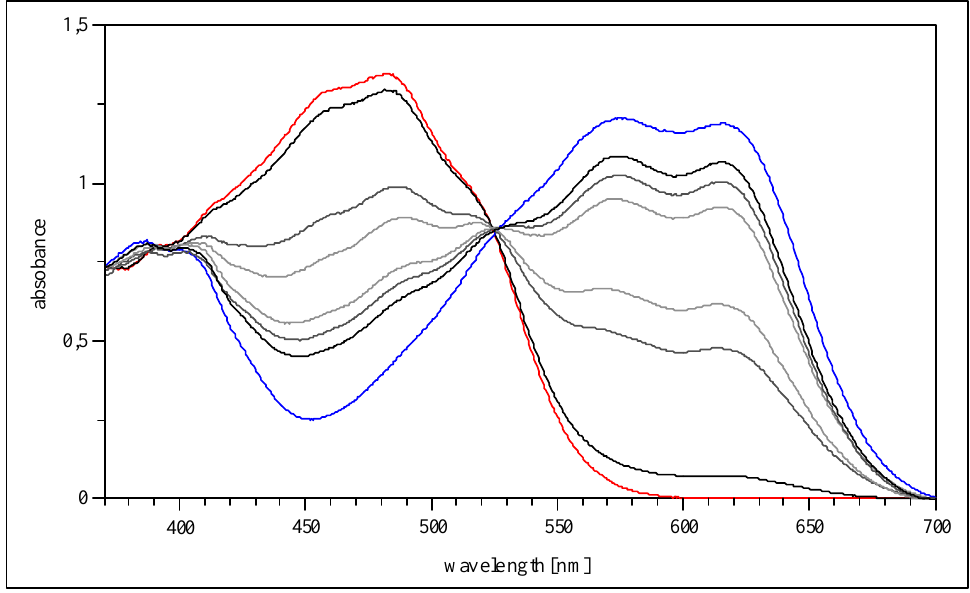
Figure 2: Isosbestic point (at 524nm, THF) during protonation of 5c .